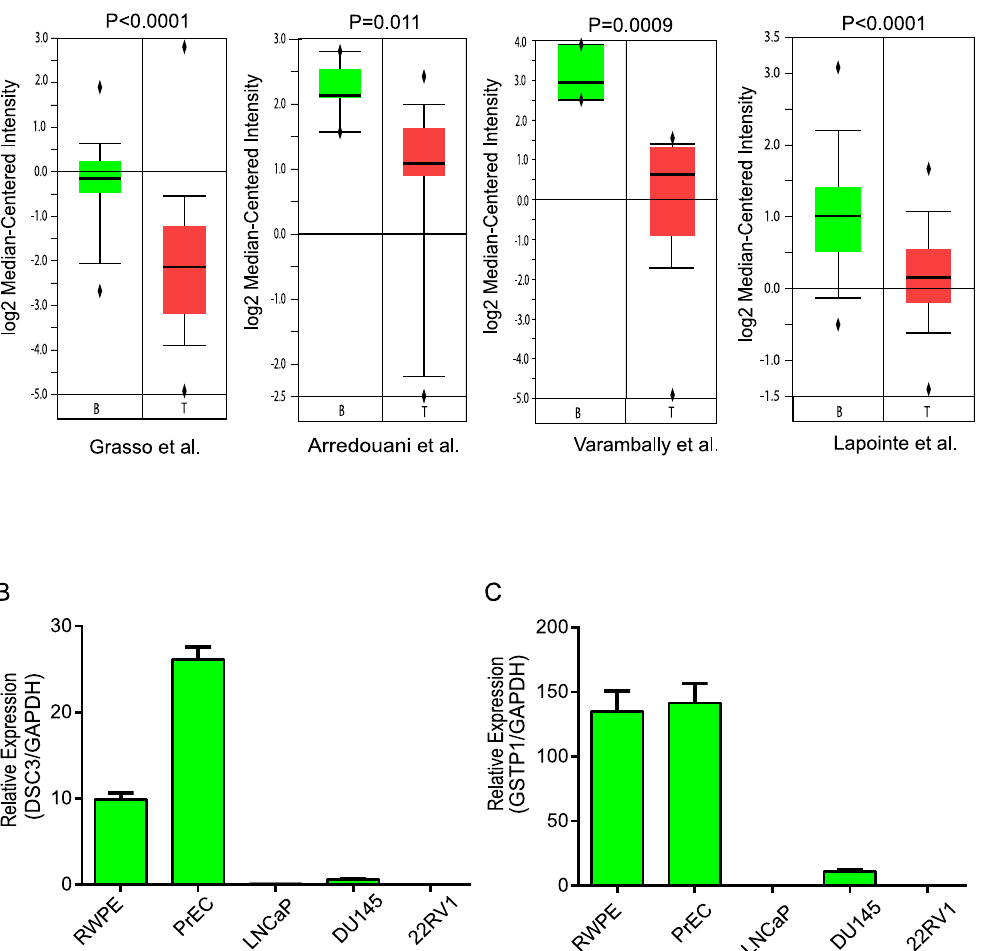
Figure 1. DSC3 Expression is Downregulated in Prostate Cancer. (A) Boxplots representation of DSC3 mRNA expression in four independent prostate cancer microarray datasets, B=Benign, T=Tumor. First author and statistical significance are indicated. (B) Q-PCR analysis of DSC3 and (C) GSTP1 expression in a panel of prostate cell lines; PrEC-prostate normal epithelial cells, RWPE-benign prostate cell line, LNCaP, Du145, 22RV1 are metastatic prostate cancer cell lines.